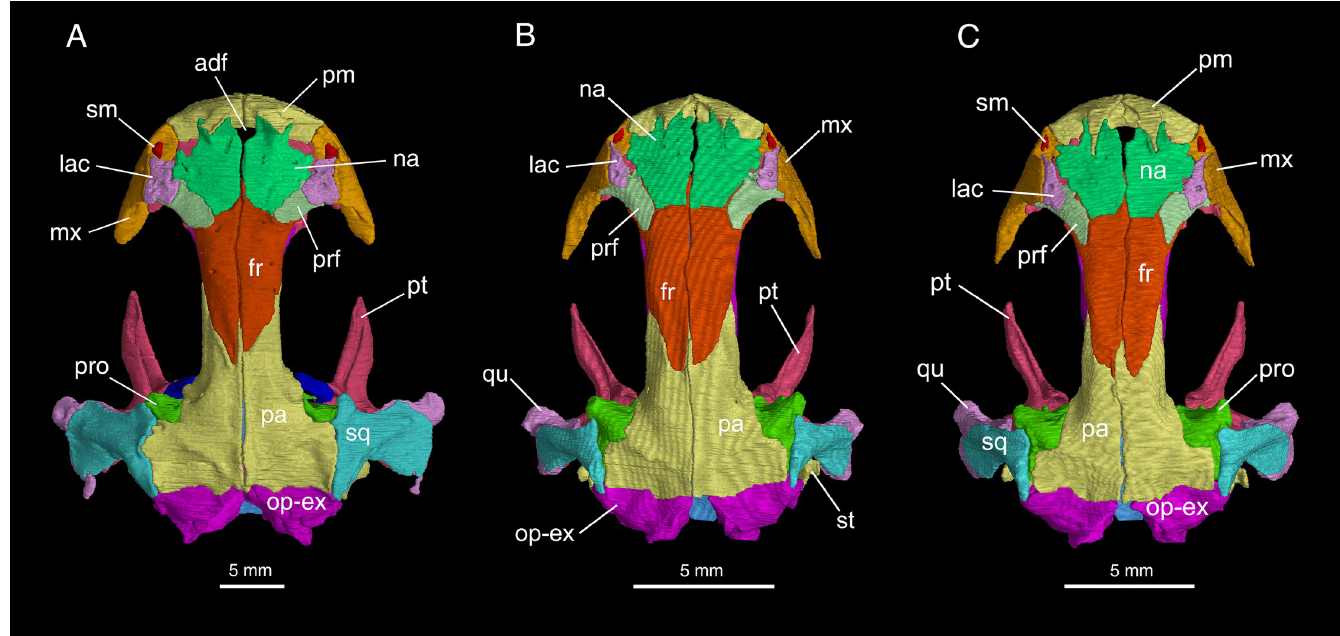
Fig 3. Micro-CT rendered reconstruction of the skull of Batrachuperus yenyuanensis in dorsal view. A, CIB 72599 from Tuowu, Mianning County; B, FMNH 49371, paratype specimen from the type locality Shuangertang, Yanyuan County; C, CIB 17308 from Shuangertang, Yanyuan